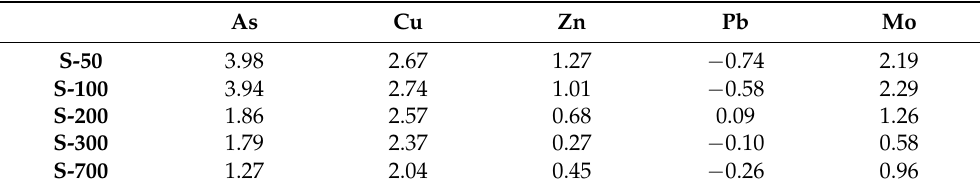
Table 3. I geo of the investigated HMs in the soil located at different distances from the Alaverdi copper smelter. As